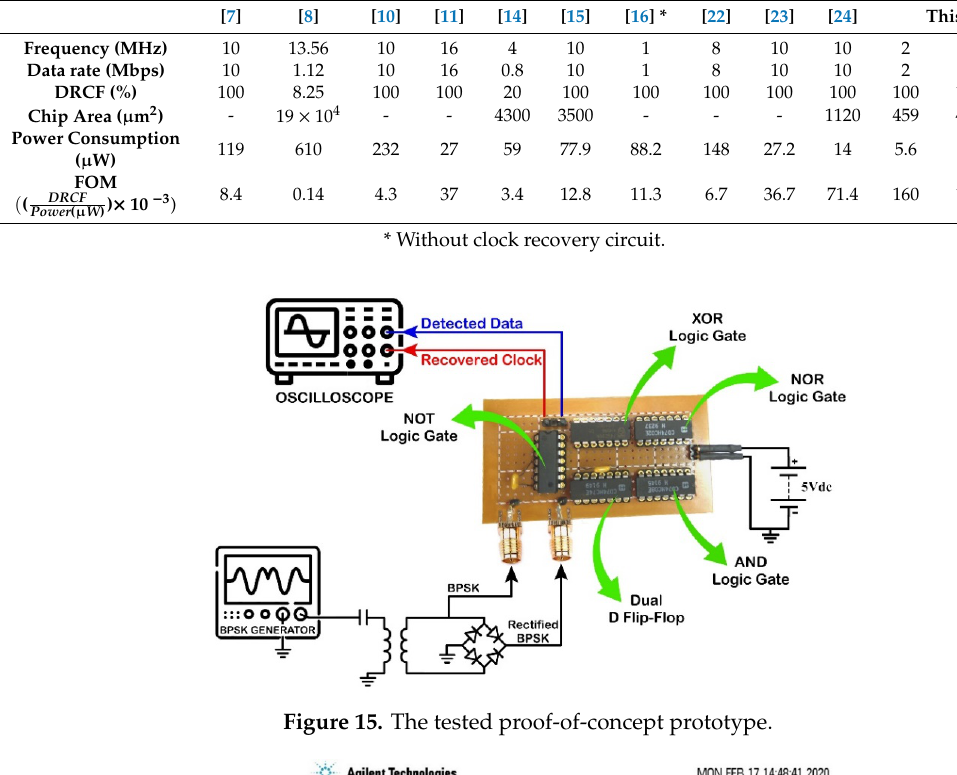
Table 3. Performance comparisons with other similar works.